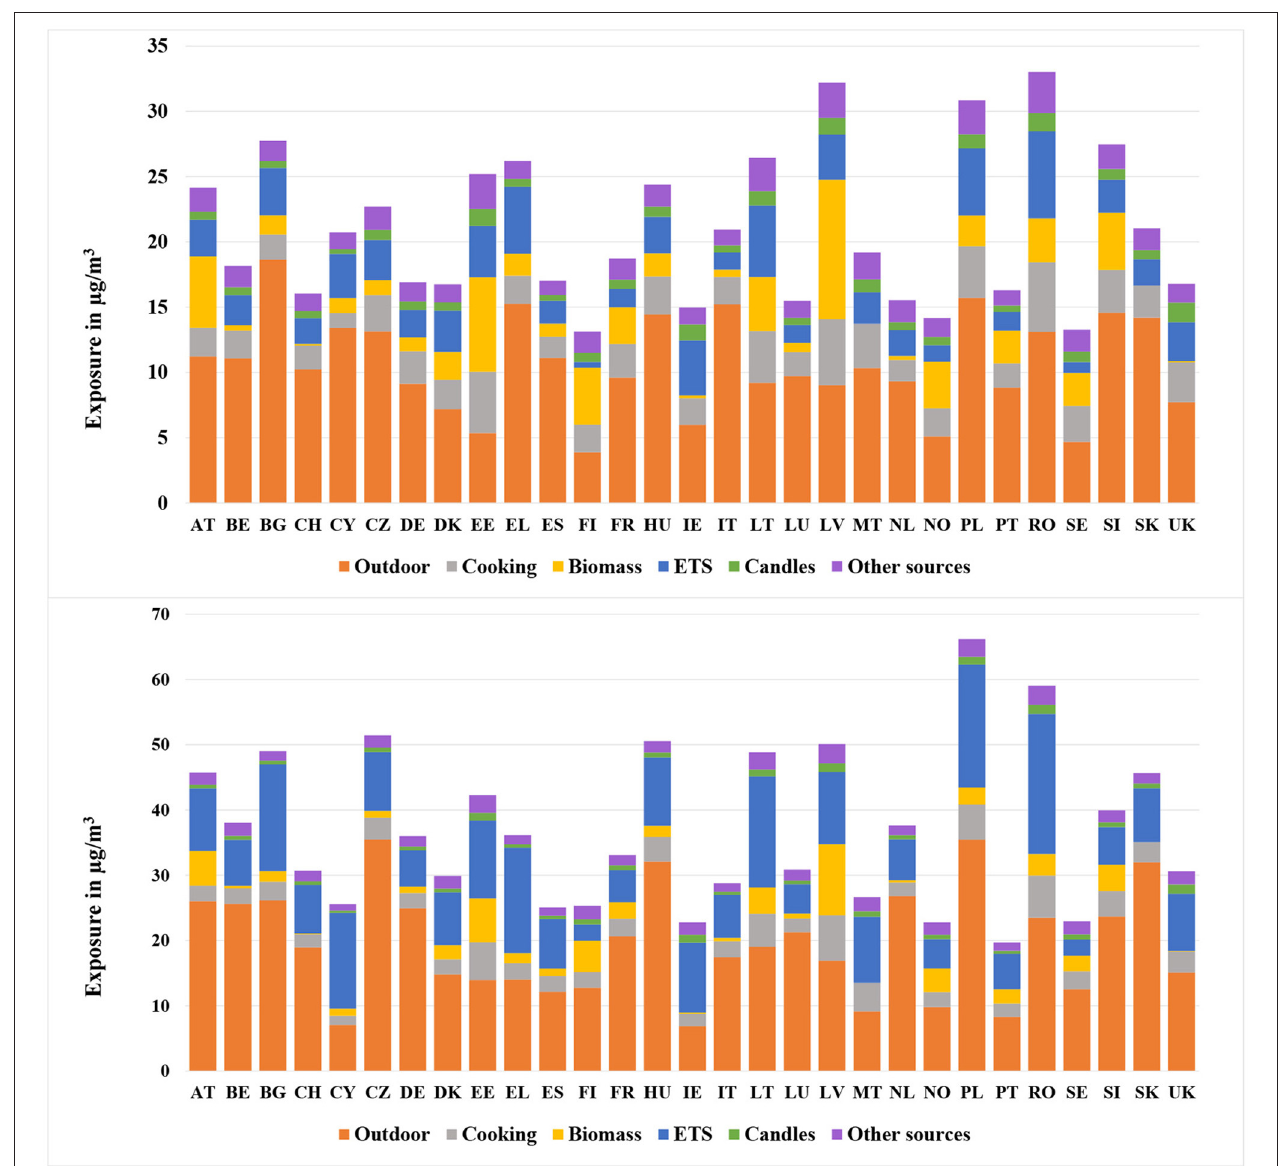
FIGURE 5 | Population-weighted arithmetic mean PM2.5 exposure for different European countries in 2015 (upper) and 1980 (lower).